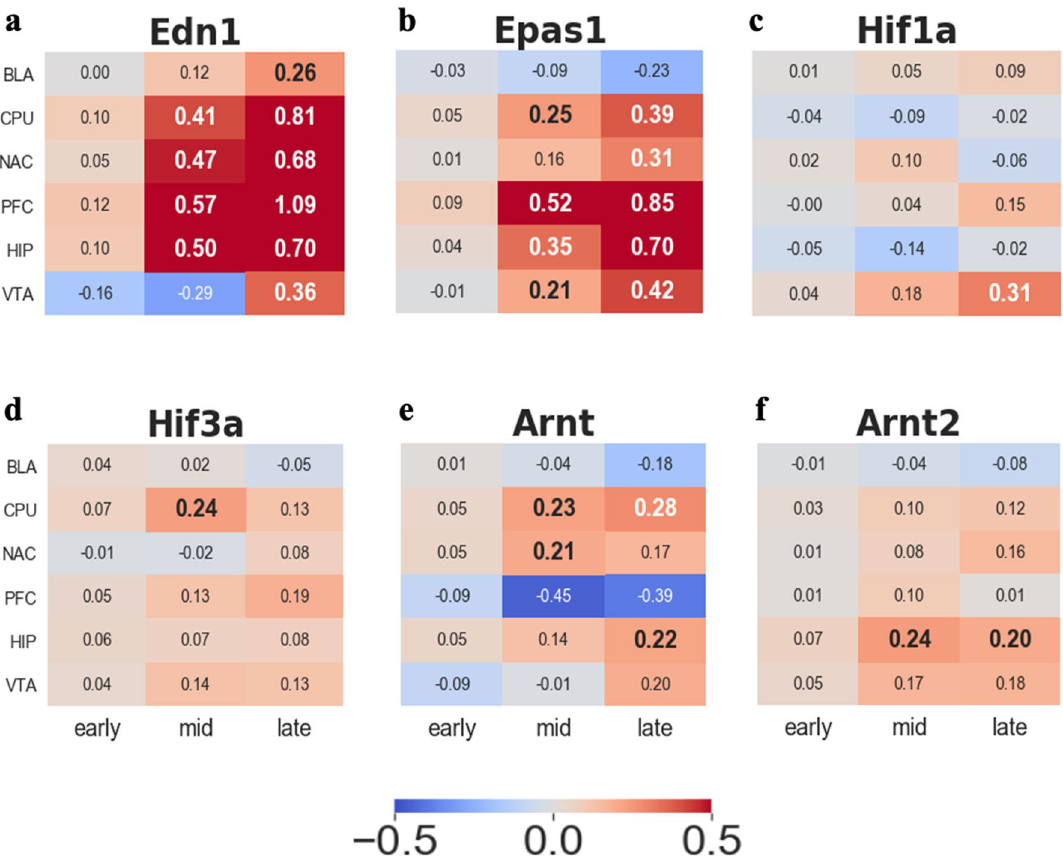
Figure 2. Log2FC trend for hypoxia-related genes. All the numbers in the heatmap indicates Log2FC trend value. ( a ) Endothelin1 ( Edn1 ) ( b ) Endothelial PAS domain-containing protein 1 ( Epas1 ) ( c ) Hypoxia-inducible factor 1-alpha ( Hif1a ) ( d ) Hypoxia-inducible factor 3-alpha ( Hif3a ) ( e ) aryl hydrocarbon receptor nuclear translocator ( Arnt ) ( f ) aryl hydrocarbon receptor nuclear translocator 2 ( Arnt2